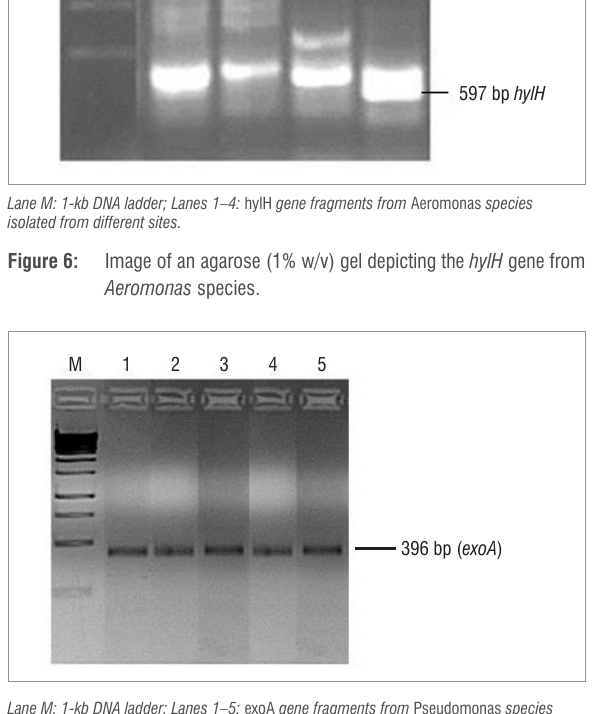
Figure 7: Image of an agarose (1% w/v) gel depicting the exoA gene from Pseudomonas species.